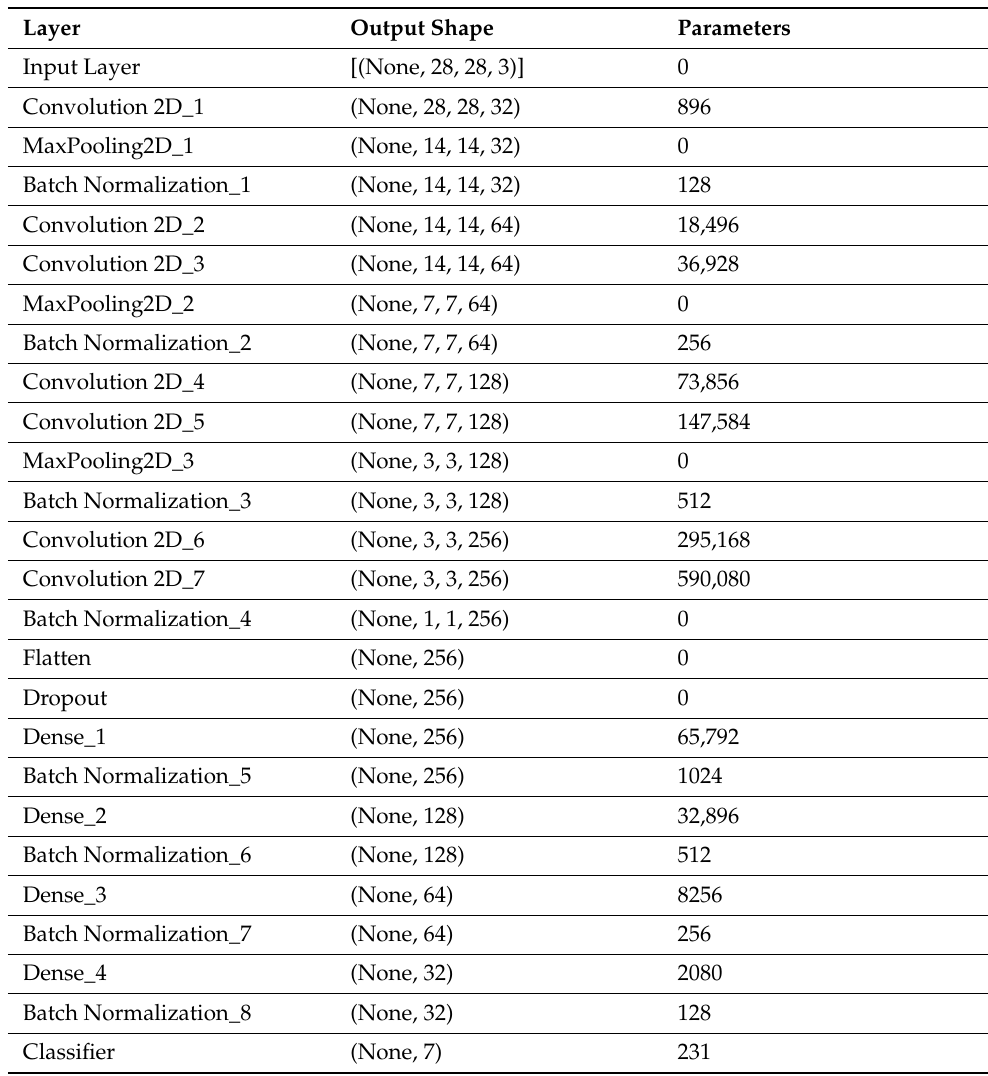
Table 3. CNN Model Summary.